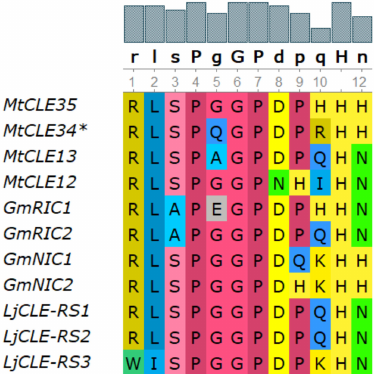
Figure 1. Sequence alignment of CLAVATA3 / ENDOSPERM SURROUNDING REGION-related (CLE) domains from Medicago truncatula, Glycine max and Lotus japonicus nodulation-suppressing CLE peptides.